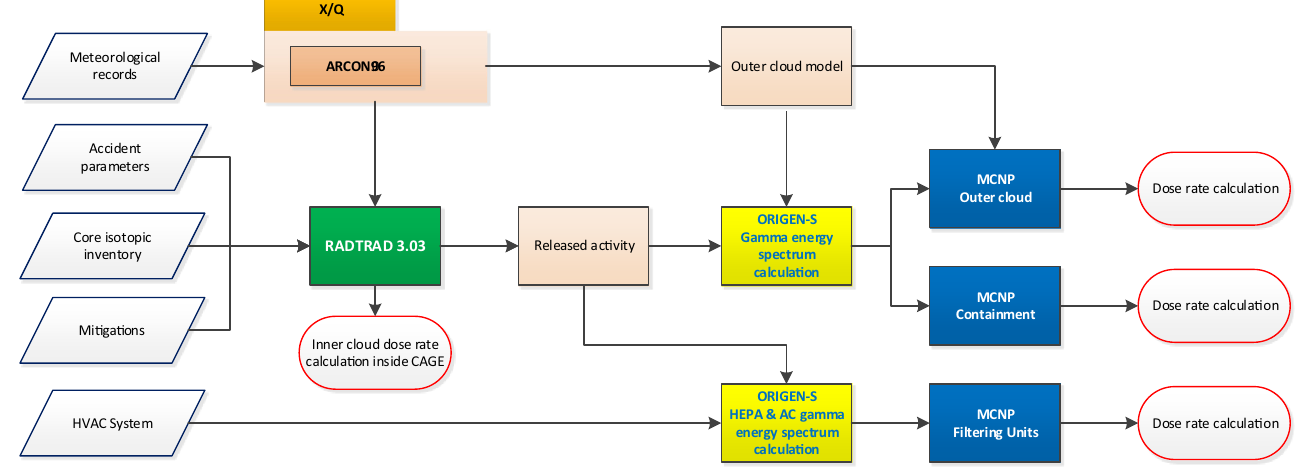
Fig. 1. Methodology applied to determine different